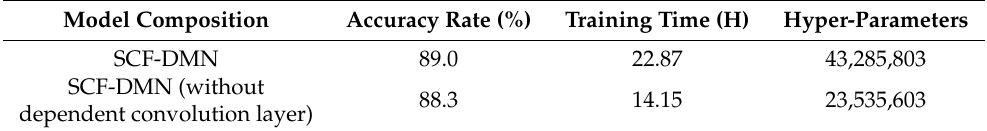
Table 7. Comparison of effects of dependent convolution layer on SCF-DMN model performance.